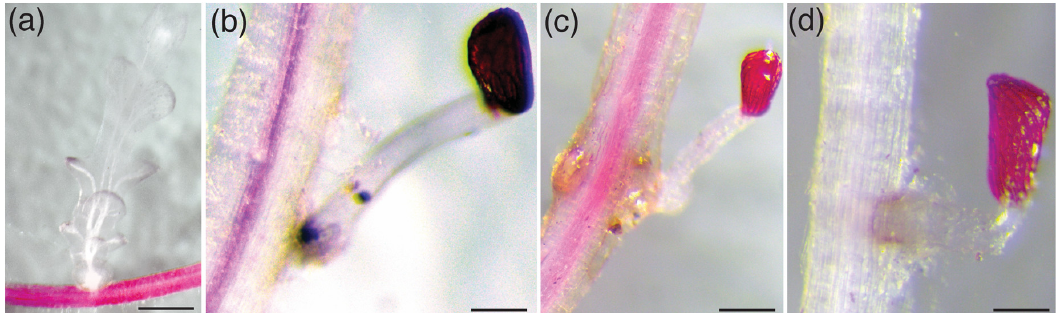
Figure 2. Levels of post germination interactions in compatible Striga -maize and incompatible Striga- Crotalaria . ( a ) Compatible Striga -maize interactions in a local maize landrace Namba Nane showing successful parasite penetration and a successful Striga -host xylem bridge. Soon after attachment and vascular connection, the parasite rapidly developed and became vegetative. Scale = 0.5 cm. ( b – d ) Di ff erent levels of Striga - Crotalaria incompatible interactions illustrated by ( b ) high incompatibility in the landrace MKS218 where the parasite was unable to attach; ( c ) where the parasite managed to penetrate Crotalaria but was blocked immediately after attachment (MKS204) and ( d ) furthest penetration of Striga into non-host tissue where the parasite appeared to approach the host vascular cylinder (BMG234). Scale = 1 mm. All interactions were determined 9 days after infection (DAI).